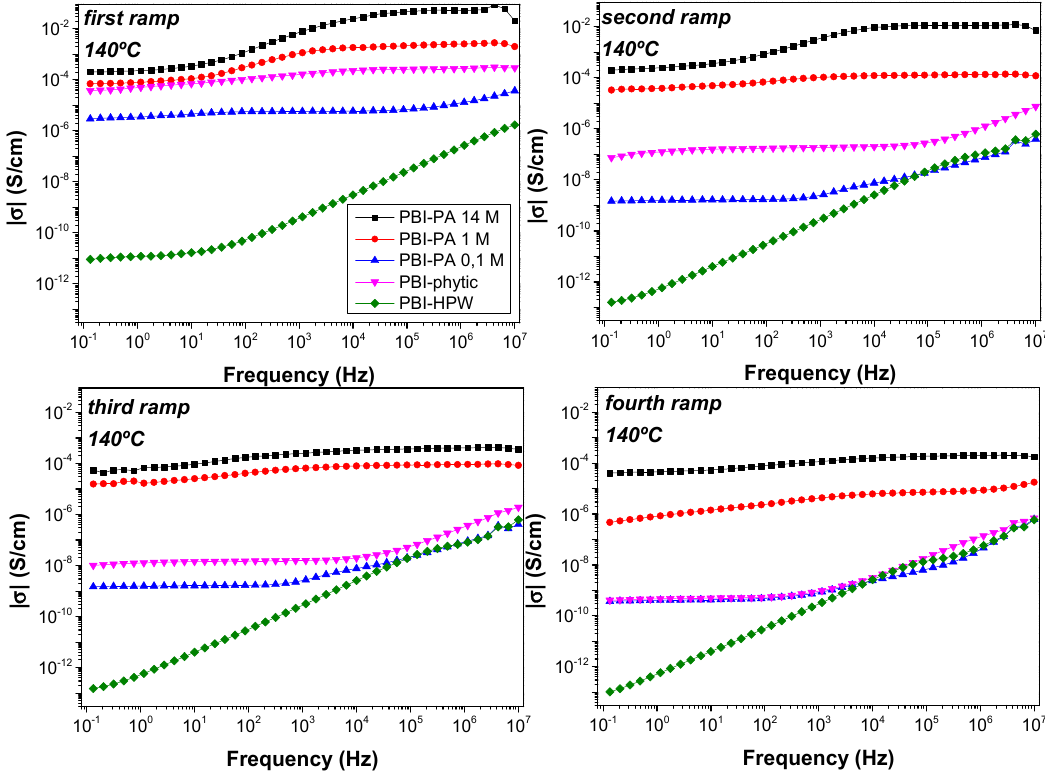
Figure 6. Bode diagrams at 140 °C for the acid-doped membranes: PBI–PA 0.1 M ( ), PBI–PA 1 M ( ), PBI–PA 14 M ( ),PBI–phytic acid ( ), and PBI–HPW ( ) measured in different cycles.